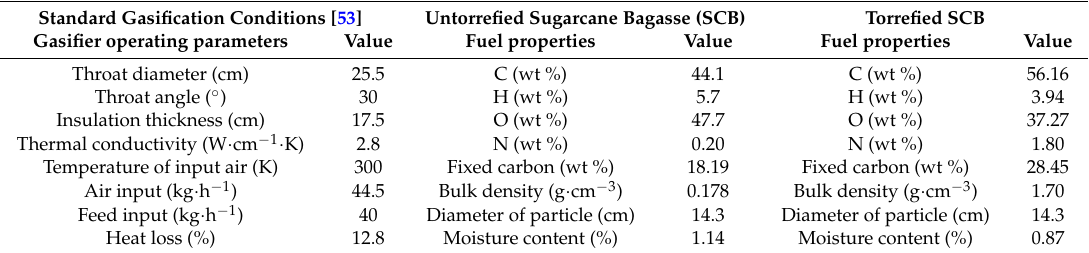
Table 1. Parameters used during computer simulation of the gasification processes of torrefied and untorrefied sugarcane